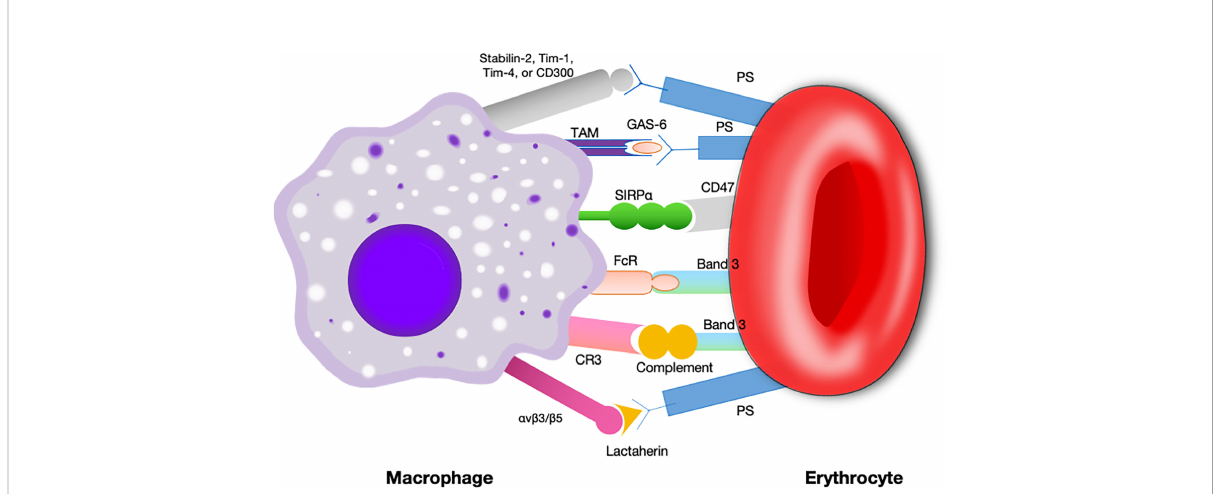
FIGURE 3 Signals involved in the interaction between macrophages and erythrocytes regulating clearance.Macrophages exhibit some receptors for phosphatidylserine, such as Tim- 1, CD300, Stabilin-2, and Tim-4, which are presumed to deliver a pro-phagocytic signal (34 – 37). Band 3 is the major target of Nabs. Band 3 clustering and opsonization with Nabs and complements on the erythrocytes facilitates binding to the macrophage via Fc receptors and CR-1 and thereby promotes phagocytosis (38, 39). CD47 is a “ don ’ t eat me ” signal that plays a crucial role in erythrocytes homeostasis. Binding of CD47 to SIRP a generates an erythrocyte phagocytosis-associated deactivation of myosin IIA, which is a primary contributor to phagocytosis because of its participation in macrophage actinomyosin contraction. Tim, T cell immunoglobulin; Nabs, natural occurring antibodies; CR-1, complement